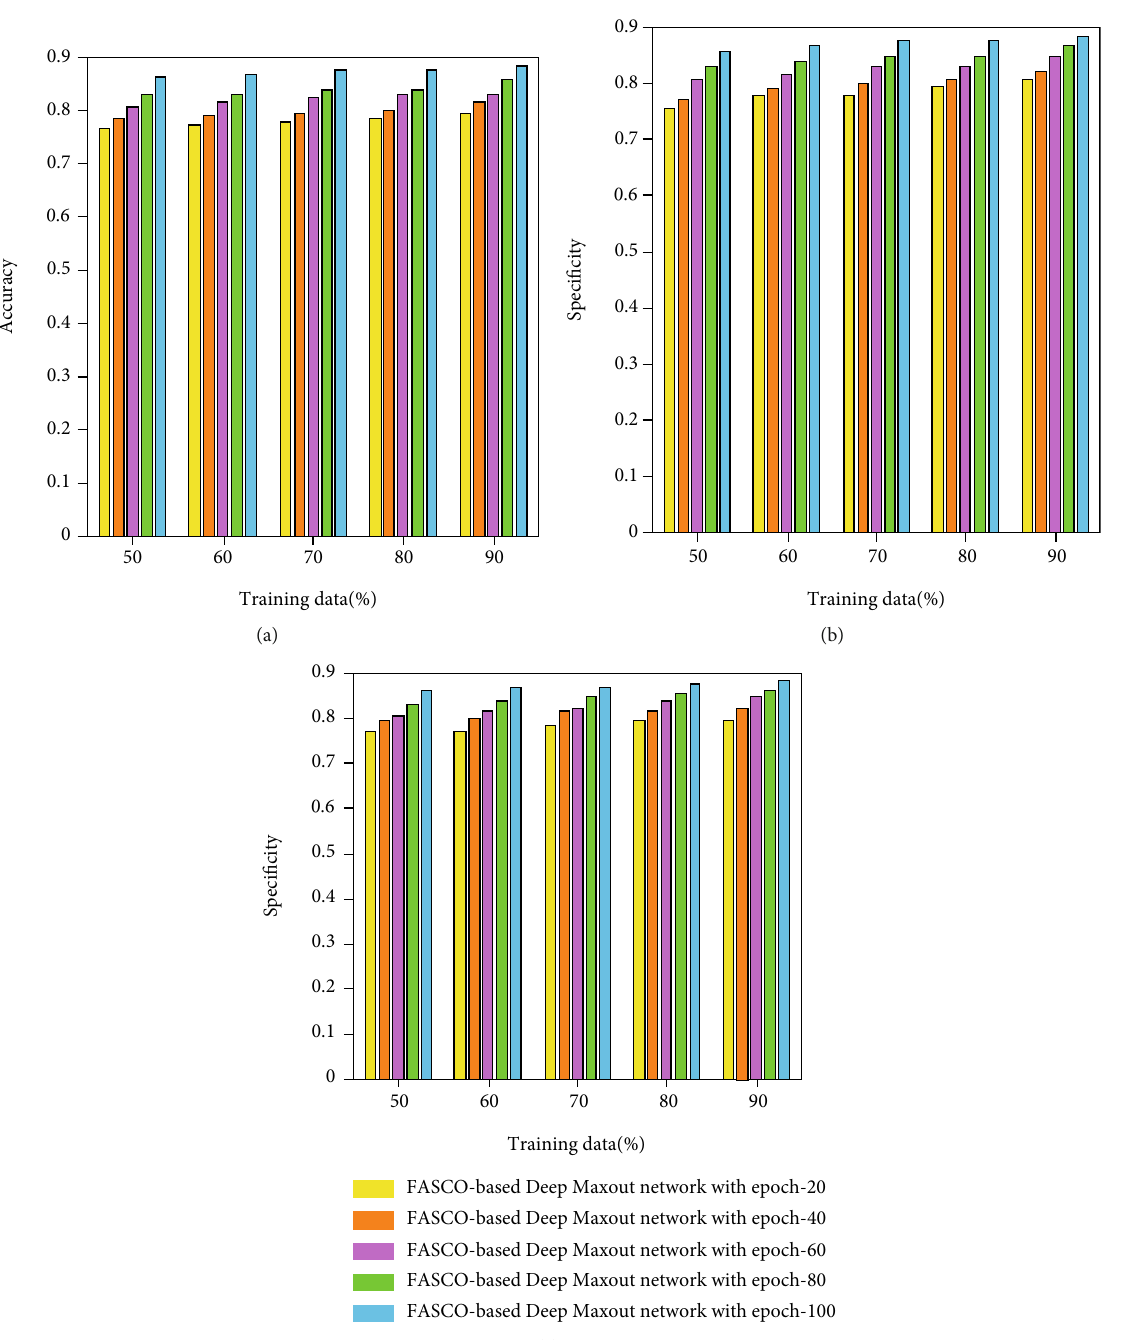
Figure 4: Performance assessment of FASSO-based deep maxout network using training data: (a) accuracy, (b) speci fi city, and (c)